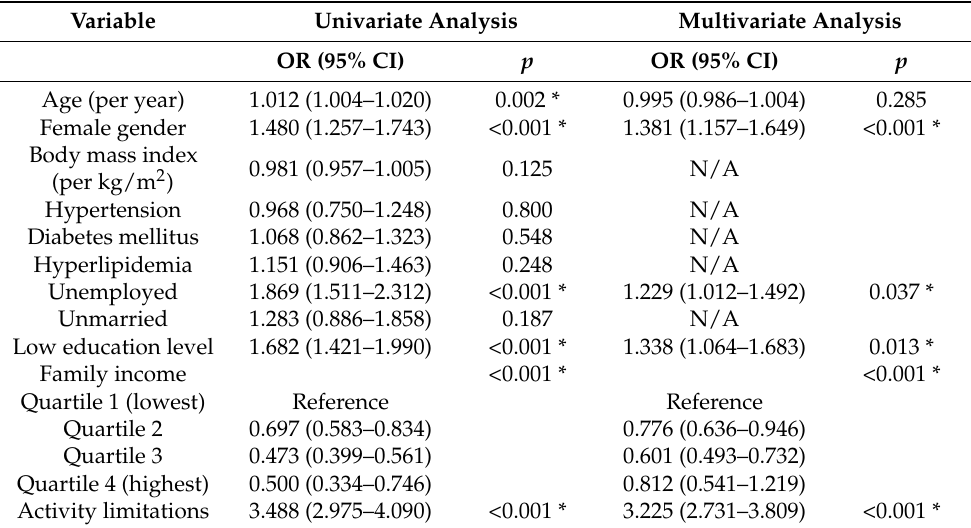
Table 3. Complex sample logistic regression analysis for depressive symptoms in stroke survivors.